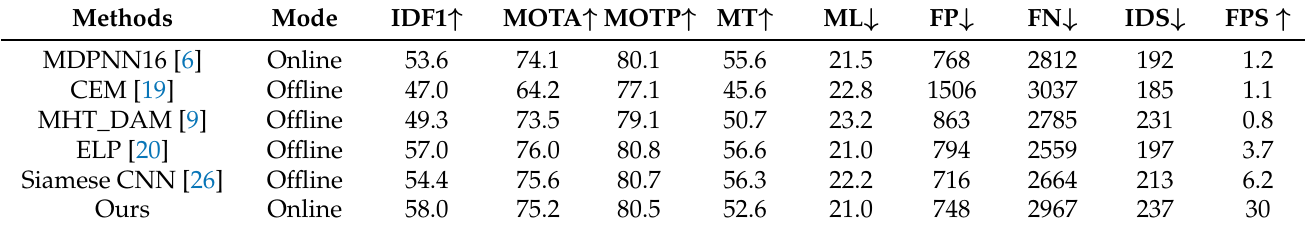
Table 2. Comparison with state of the art on the APIDIS